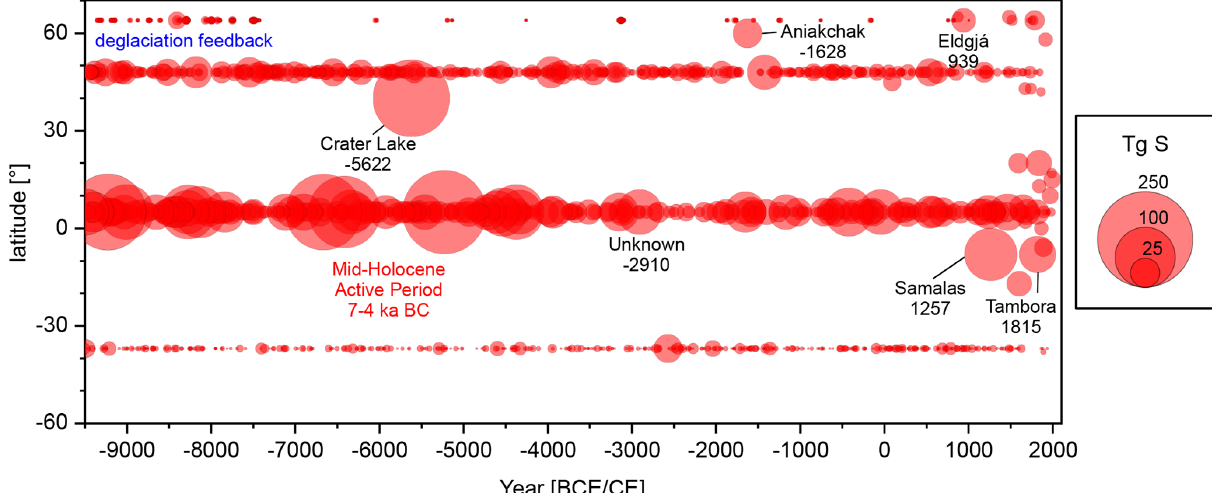
Figure 6. Spatiotemporal distribution of volcanic stratospheric sulfur injections from volcanic eruptions since 9500BCE from HolVol 1.0 based on known and assigned locations (Iceland, 64 ◦ N; NHET, 48 ◦ N; tropics, 5 ◦ N; SHET, 37 ◦ S). Only eruptions with VSSI > 1TgS are included; prominent historic and prehistoric eruptions are marked; source attributions for Aniakchak and for Crater Lake are based on the geochemistry of cryptotephra from Greenland ice cores (Coulter et al., 2012; Zdanowicz et al.,